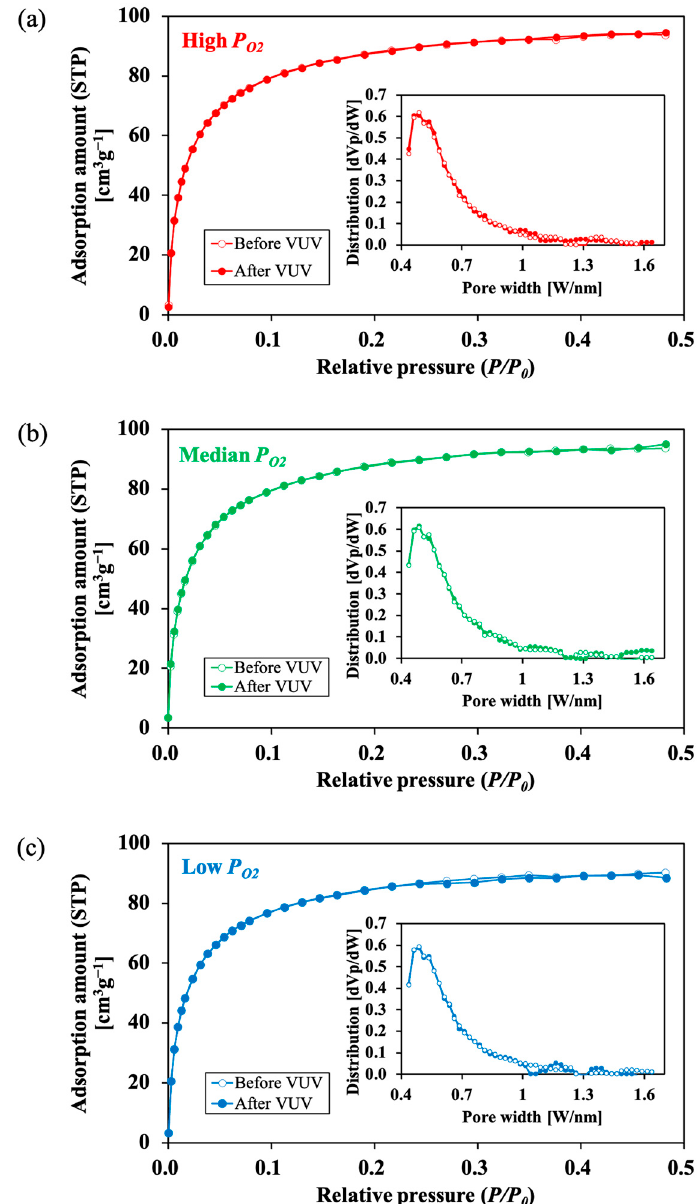
Figure 4. CO 2 adsorption isotherms of films of woody carbon material from 0 to 0.48 relative pressure: ( a ) High P O 2 condition, ( b ) median P O 2 condition, ( c ) low P O 2 condition, and ( d ) all condition. Inset: Micropore distribution dV p /dW analyzed by Horvath-Kawazoe method.